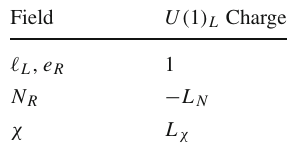
Fields that are not listed here do not transform under LN